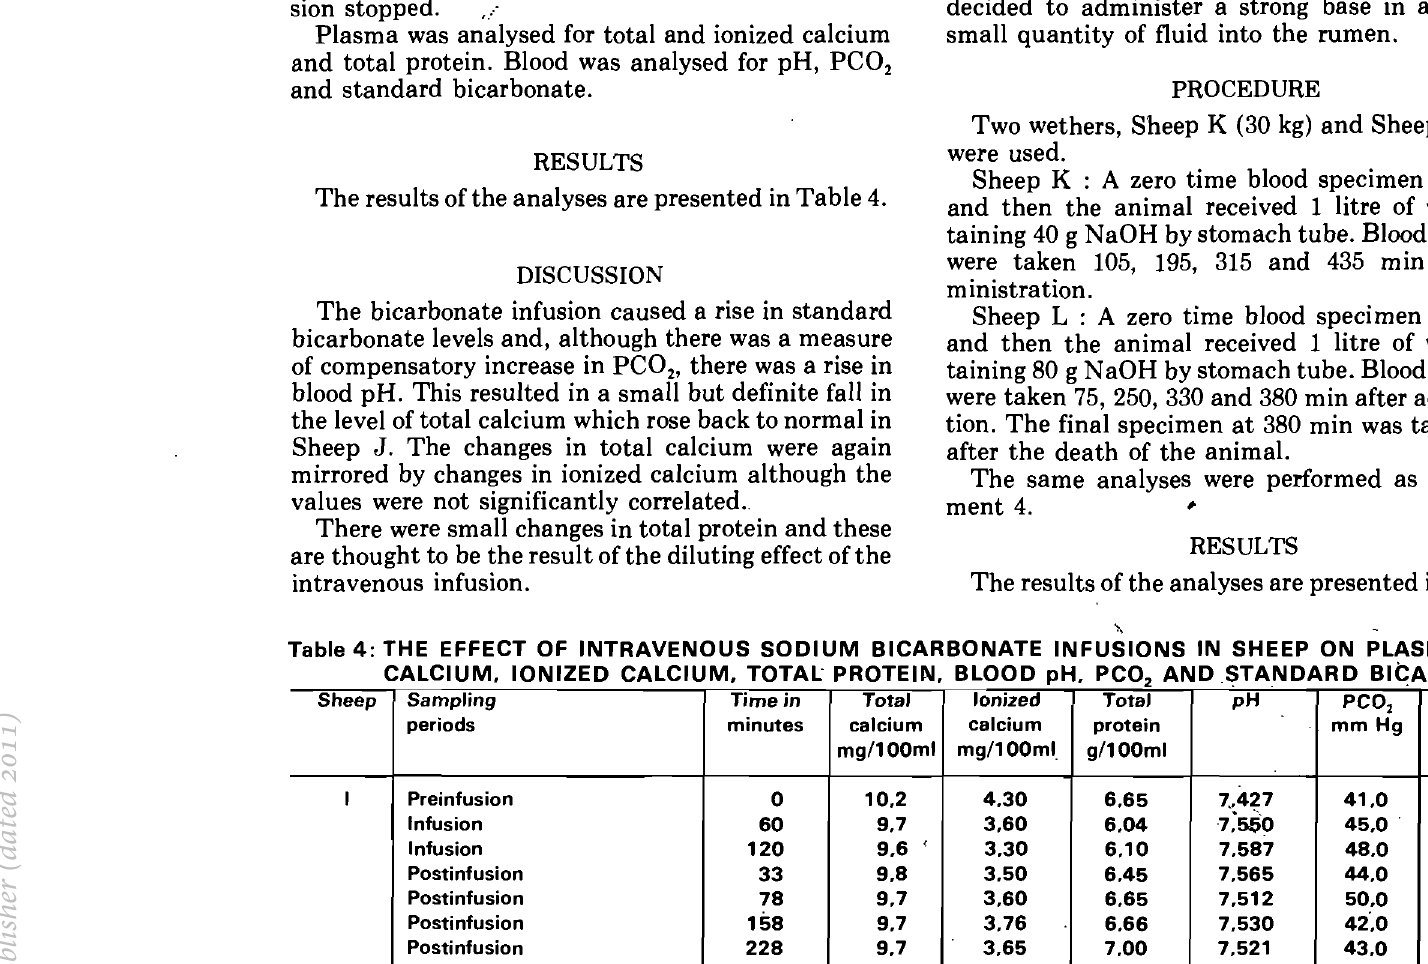
Table 4: THE EFFECT OF INTRAVENOUS SODIUM BICARBONATE INFUSIONS IN SHEEP ON PLASMA TOTAL